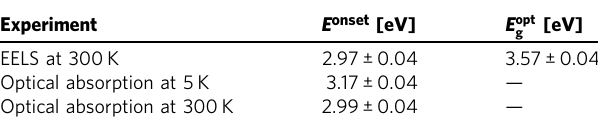
Table 2 Absorption onset, E onset , given by the energy of the fi rst indirect transition, and optical gap, E opt the fi rst direct excitation, as obtained by the EELS and optical absorption measurements 22 .